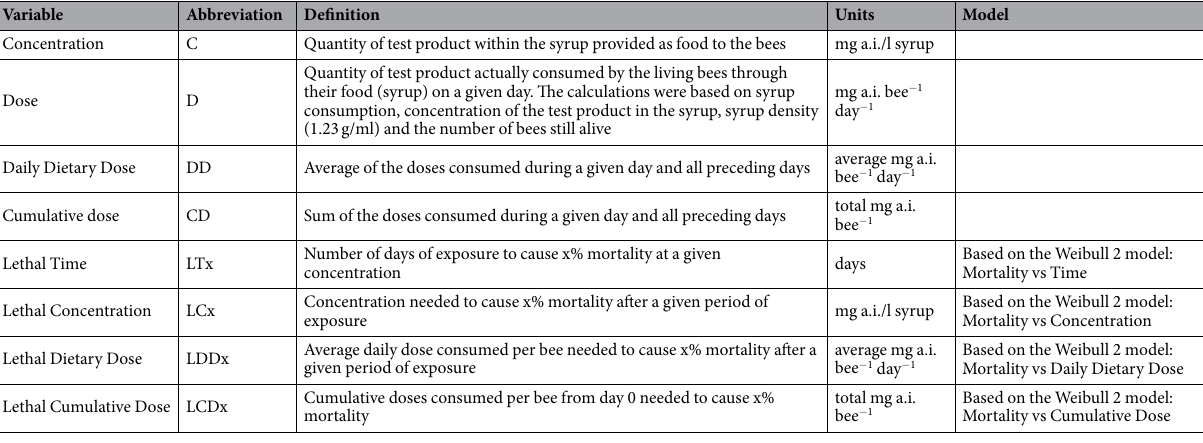
Table 1. Definitions and abbreviations of the toxicological